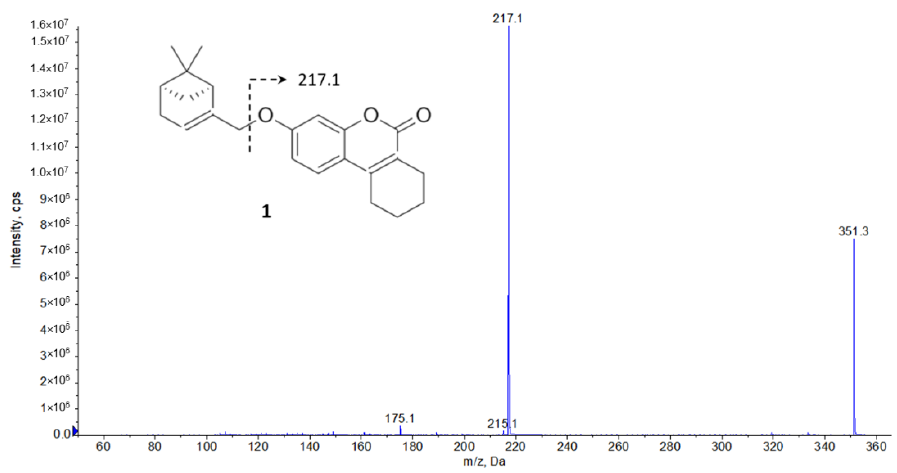
Figure 2. Mass spectrum of the agent K-142 (compound 1 ) after collision-induced Figure 2 . Mass spectrum of the agent K-142 (compound 1 ) after collision-induced dissociation.